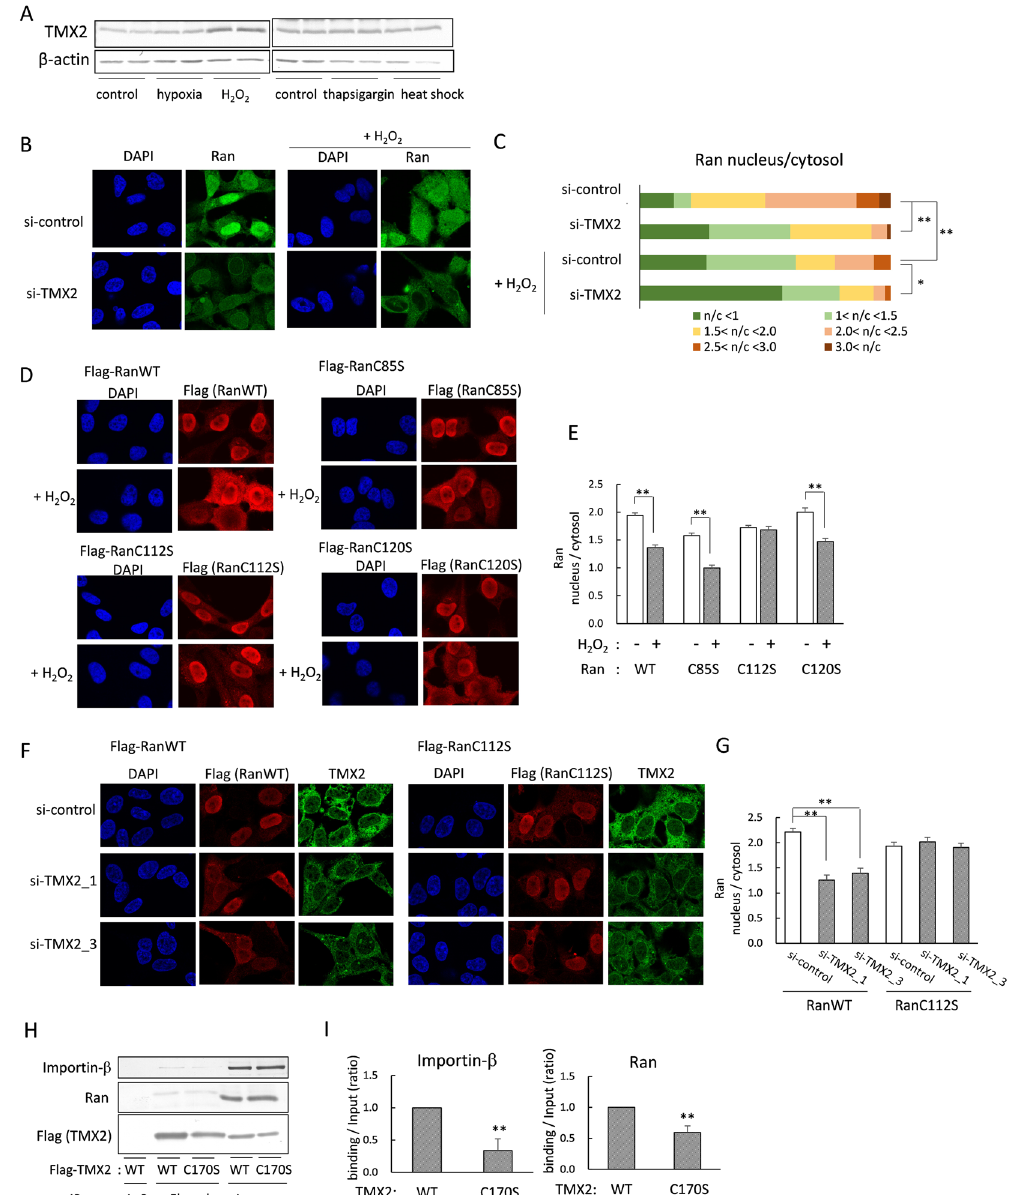
Figure 6. The cysteine 112 of Ran was involved in the regulation of Ran gradient by TMX2. ( A ) HEK293 cells were cultured under 1% oxygen concentration for 6 h or heat stress condition at 42 °C for 3 h, or in the presence of 200 μ M H 2 O 2 for 4 h or 200 nM thapsigargin for 4 h, and TMX2 protein induction was investigated. ( B ) Hela cells were lipofected with si-control or si-TMX2, and treated with 200 μ M H 2 O 2 for 20 min. After fixing with PFA, the endogenous Ran distribution was observed by immunofluorescence microscopy. ( C ) The Ran nucleus/ cytosol signal-intensity ratios of about 40 cells were quantitated. ( D ) Flag-Ran WT, C85S, C112S, or C120S was expressed in Hela cells, and the cells were treated with 200 μ M H 2 O 2 for 30 min. The localization of Ran was analyzed by immunostaining with anti-Flag antibody. ( E ) The nucleus/cytosol ratio of Ran was quantified in about 45 cells. Values are the means ± S.E. ( F ) Ran WT or C112S/Flag pcDNA was co-transfected with si- TMX2 into cells. After 48 h, the localization of Ran was analyzed by anti-Flag antibody. Knockdown of TMX2 was confirmed by anti-TMX2 antibody. ( G ) The nucleus/cytosol ratio of Ran was quantified in about 40 cells. ( H ) HEK293 cells were overexpressed with Flag-tagged TMX2 WT or C170S mutant, and the cell lysates were immunoprecipitated with anti-Flag antibody. The precipitant was analyzed by anti-importin- β or Ran antibody. ( I ) The band intensity of importin- β or Ran binding/Input was quantified. Values are the means ± S.D. for three separate experiments. The control value was set at 1.0. * p < 0.05, ** p <